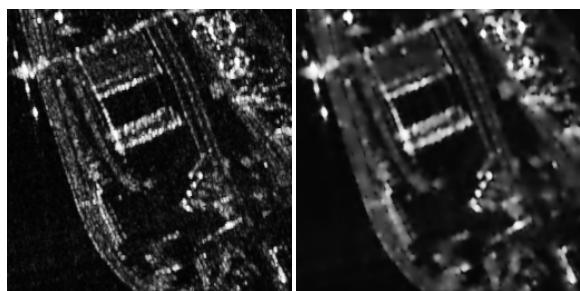
Figure 6. Subset of a TerraSAR-X spotlight acquisition over the harbor area of Mannheim-Ludwigshafen in Germany. For the left image only one number of looks is adapted, whereas for the right image multi-scale multi-looking is adapted (Schmitt et al.,